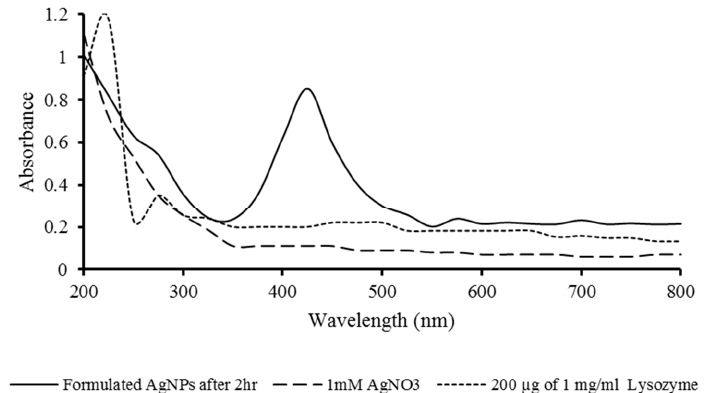
Figure 1. The UV-Visible spectrum of AgNPs was synthesized using a 10:1 ratio of 1 mM silver nitrate and 200 µL lysozyme (1 mg/mL) after 2 h incubation at 60 °C along with UV-visible spectra of a 1 mM AgNO 3 and 1 mg/mL of 200 µL